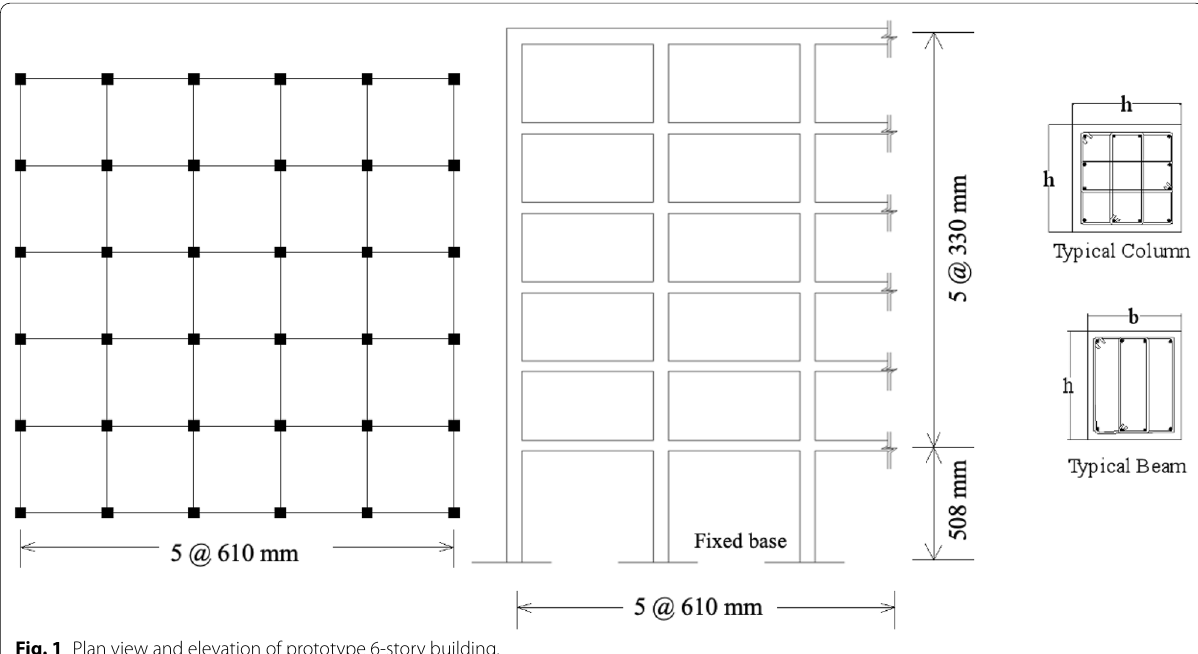
Fig. 1 Plan view and elevation of prototype 6-story building.